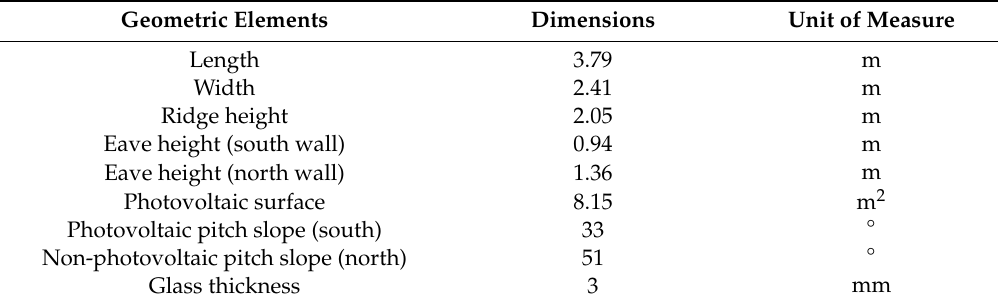
Table 1. Geometric characteristics of the prototype greenhouse.